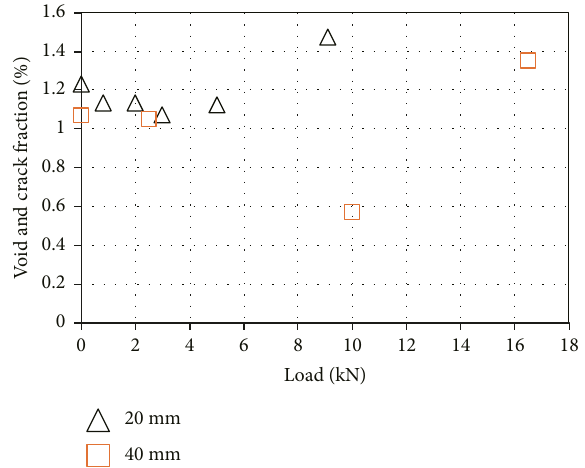
Figure 4: Evolution of volume fraction of voids and